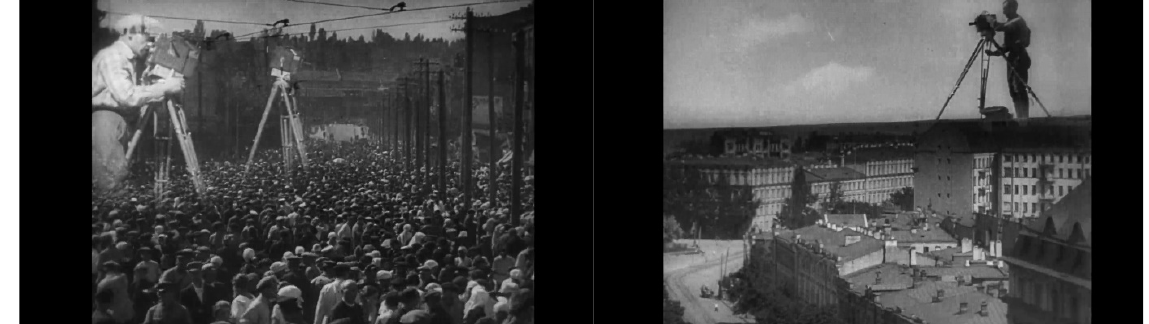
Figure 2. These superimpositions display Mikhail Kaufman’s eagle eye over the town and people’s